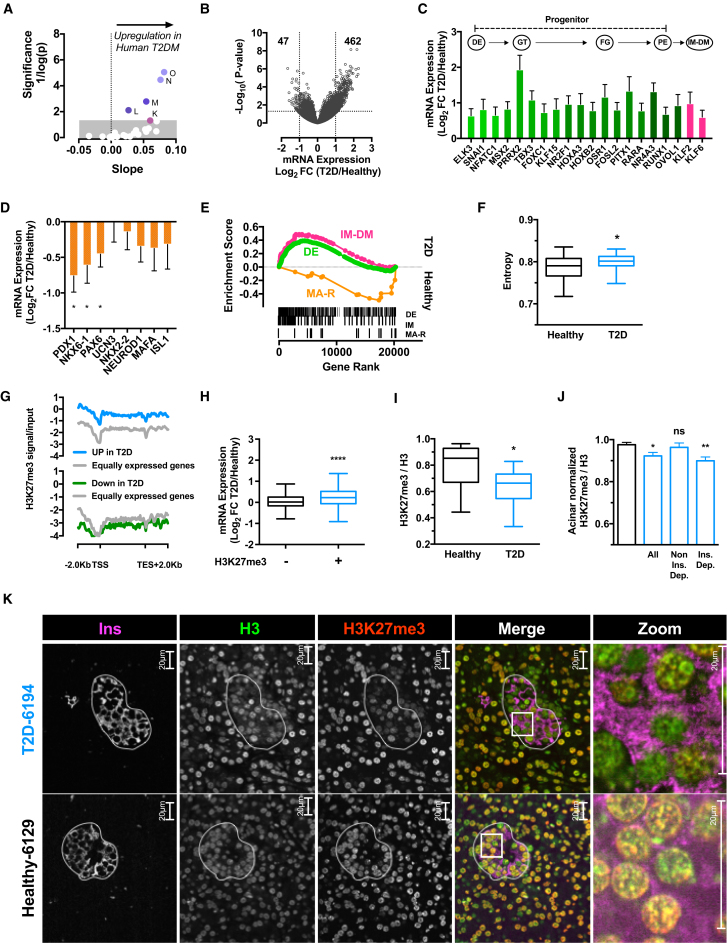
Polycomb (Dys)regulation and Dedifferentiation in Human T2D(A) Significance and correlation (slope) of human orthologs embedded in respective mouse chromatin states in human T2D states (Fadista et al., 2014). Arrow indicates direction of positive correlation with gene upregulation in human T2D tested with linear regression. Upper boundary of gray box indicates p = 0.05.(B) Volcano plot of mRNA-seq data from human T2D islets. Horizontal dotted line indicates p = 0.05, vertical lines indicates ±2-fold difference. Number of significantly up- or downregulated genes are shown.(C) Mean expression fold change of transcription factors in mRNA-seq data from human T2D islets (gene sets from DE, definitive endoderm; GT, gut tube; FG, fore gut; PE, pancreatic endoderm; Xie et al., 2013) and immature β cells (IM-DM; Blum et al., 2012). Arrows represent hypothetical developmental trajectory. Genes listed show core enrichment in gene set enrichment analysis (GSEA) analysis and are significantly different between healthy and T2D islets with false discovery rate (FDR)-q < 0.05.(D) Mean expression fold change of MBTFs between human T2D and healthy islet transcriptomes. ∗p < 0.05.(E) GSEA of definitive endoderm (DE) (Xie et al., 2013), immature (IM-DM) (Blum et al., 2012), and mature β cell genes (MA(R); REACTOME, regulation of gene expression in β cell) in human T2D islets. FDR-q < 0.05 for all gene sets shown.(F) Median entropy in T2D islet versus healthy islet transcriptomes. Boxplot whiskers indicate min to max.(G) Average H3K27me3 signal at genes up- or downregulated in T2D and equally expressed genes. TSS, transcription start site; TES, transcription end.(H) Boxplot of gene expression changes at H3K27me3 marked (+) and non-marked (−) genes in human T2D islets.(I and J) H3K27me3 immunostaining intensity in β cells of pancreatic sections from T2D donors (n = 11, blue) relative to healthy donors (n = 11, black), normalizing to H3 intensity from the same nuclei (I) and normalizing against same image acinar nuclei (J). T2D donors are combined (All) or stratified by insulin treatment dependency (Non Ins. Dep. or Ins. Dep.).(K) Representative images of a pancreatic islet (outlined) from a healthy (bottom) and T2D (top) donor pancreas sections. Zoomed-in areas are outlined in boxes.All data represent mean ± SEM, unless otherwise stated. Boxplot whiskers indicate 1.5 interquartile range, unless otherwise stated. ∗p < 0.05, ∗∗p < 0.01, ∗∗∗∗p < 0.0001. ns, not significant. See also Figure S2.